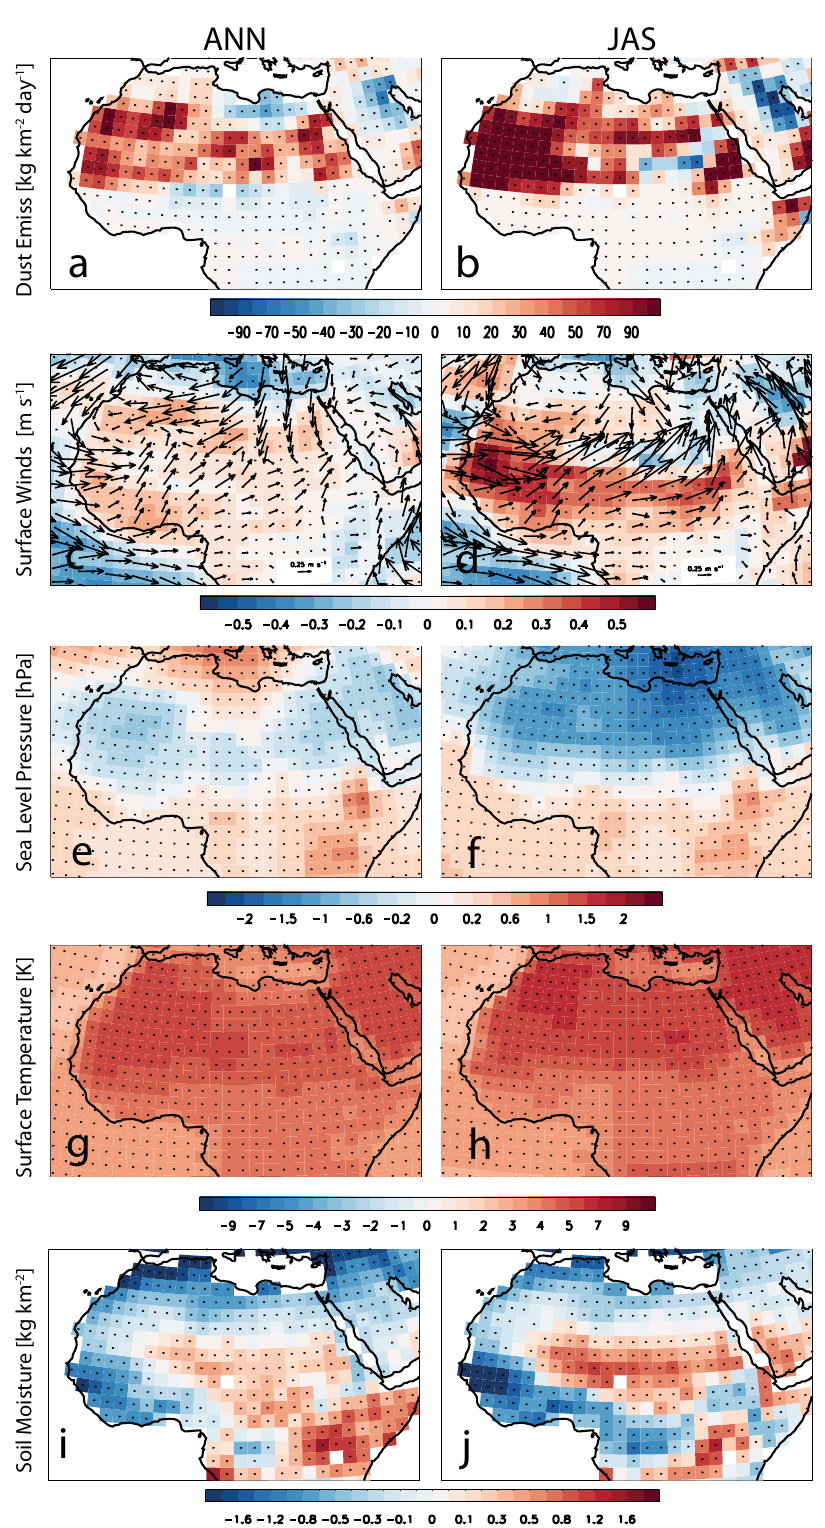
Fig. 3 Response of dust emissions and atmospheric circulation to GHG-induced warming over Africa. Multi-model mean annual mean change in a dust emissions [kg km − 2 day − 1 ]; c surface wind vectors and wind speed [m s − 1 ]; e sea level pressure [hPa]; g surface temperature [K]; and i surface soil moisture [kg km − 2 ]. Corresponding multi-model mean July – August – September (JAS) responses for b dust emissions [kg km − 2 day − 1 ]; d surface wind vectors and wind speed [m s − 1 ]; f sea level pressure [hPa]; h surface temperature [K]; and j surface soil moisture [kg km − 2 ]. Dots represent a signi fi cant response at the 90% con fi dence level based on a two-tailed pooled t -test.